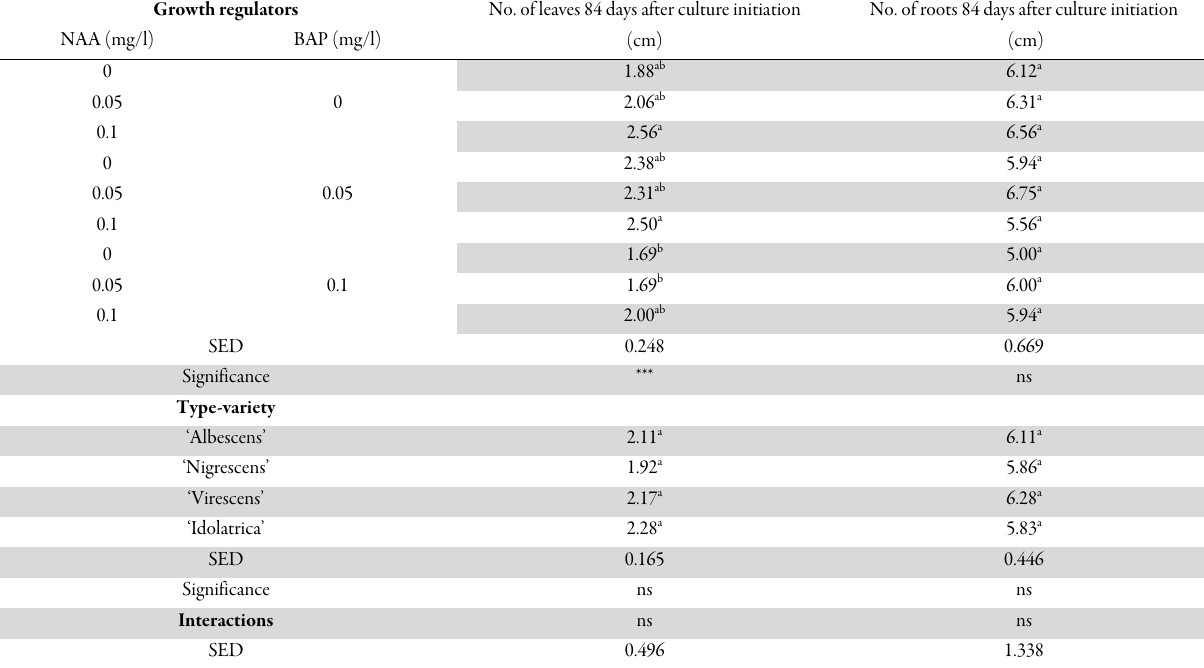
Table 3. Effects of growth regulators and type-variety of oil palm on the number of leaves and roots at 84 days after culture initiation Growth regulators